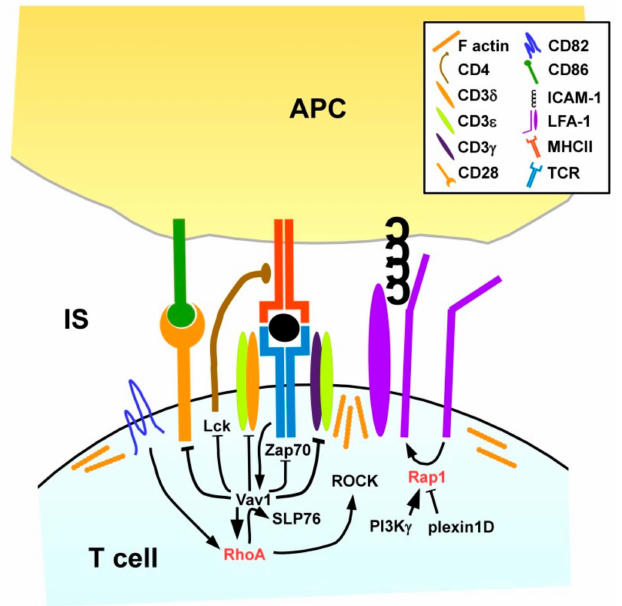
Figure 8. Activation of antigen-specific T cells by APC via receptor pairs localized within the IS results in RhoA activation. Recognition of the MHC / antigen complex by the TCR, concomitant co-stimulation via CD86 / CD28 and ICAM / LFA-1 dependent adhesion results in activation of the Rho / Rac GEF Vav1. CD82 further promotes Vav1 activation / interaction with SLP76 in a RhoA-dependent manner. Active Vav1 activates small GTPases, and inhibits TCR components and CD28 to prevent excessive T cell